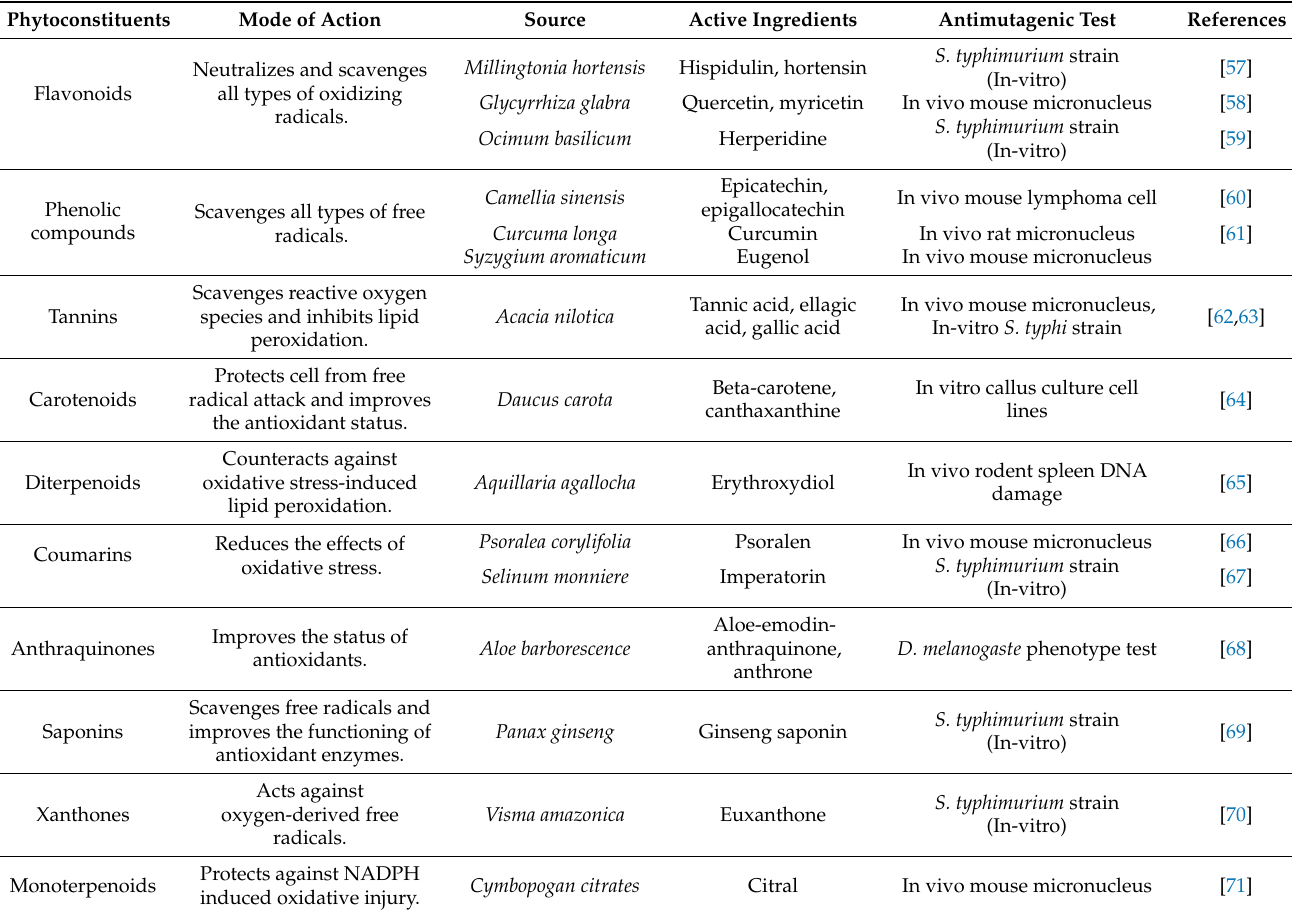
Table 1. Some important plants having antioxidant and anti-mutagenic